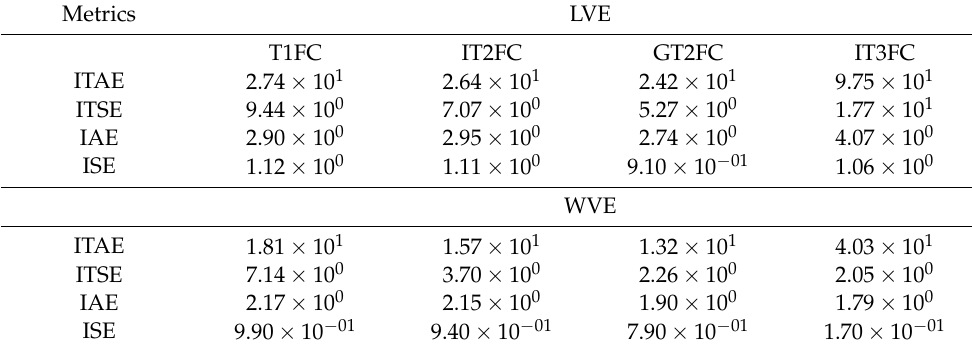
Table 9. Metrics results with PG.